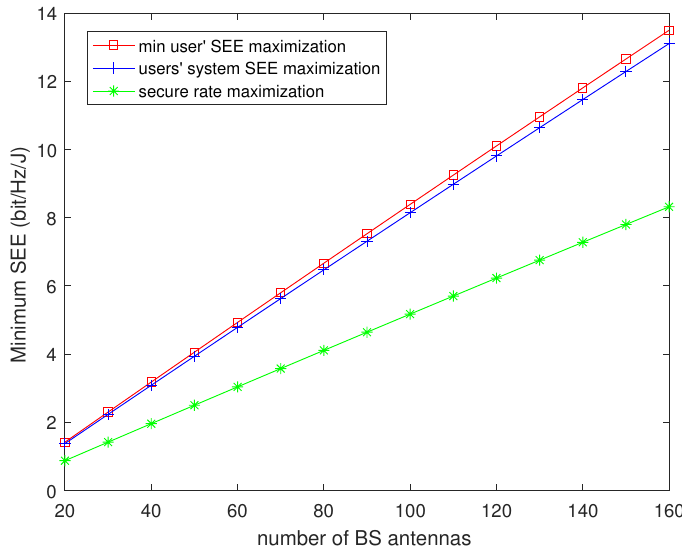
Figure 3. Minimum SEE under a different number of BS antennas.